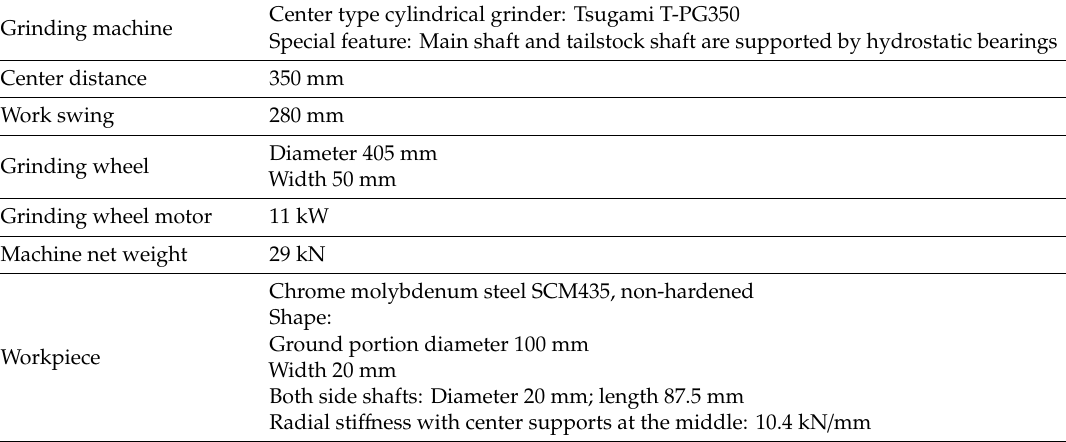
Table 1. Specifications of applied grinding machine and workpiece.